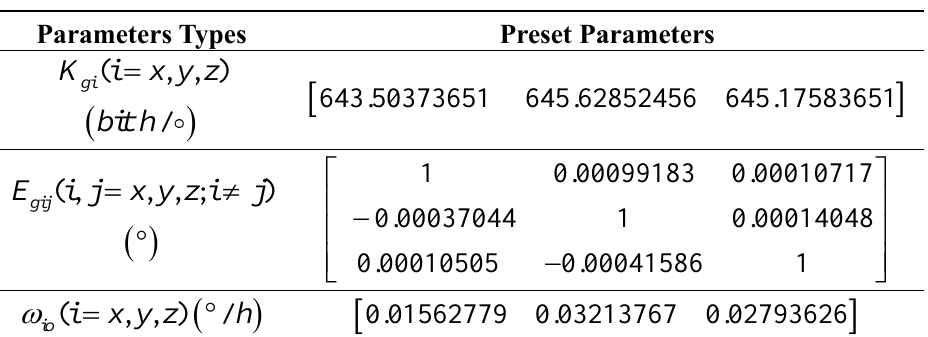
Table 2. Preset FOG error